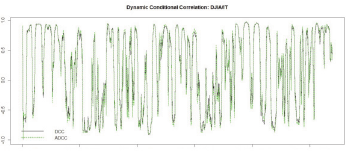
Fig. 6. Dynamic Conditional Correla- tion at D1 Scale